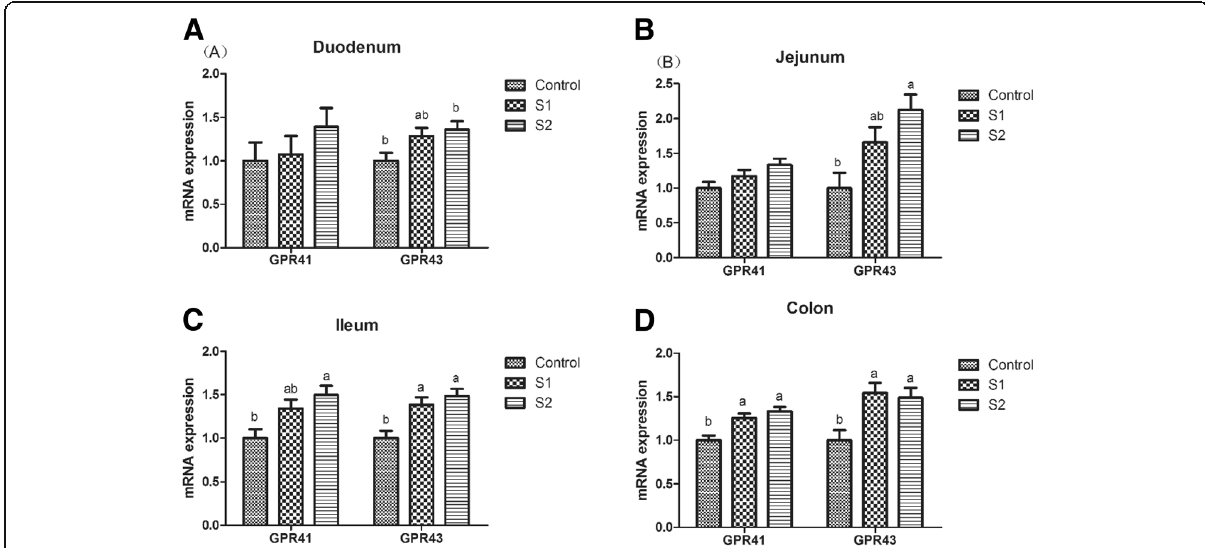
Fig. 1 Effect of gastric infusion of SCFA on the relative mRNA expressions of SCFA receptors in ileum and colon of growing pigs. S1, pigs treated with SCFA (acetic, propionic, and butyric acids; 20.04, 7.71, and 4.89 mM respectively); S2, pigs treated with SCFA (acetic, propionic, and butyric acids; 40.08, 15.41, and 9.78 mM respectively). a, b, means without a common superscript difference ( P < 0.05)